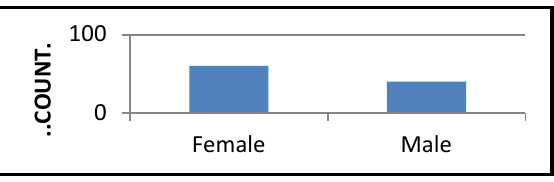
Figure (4):Relation ship between number of